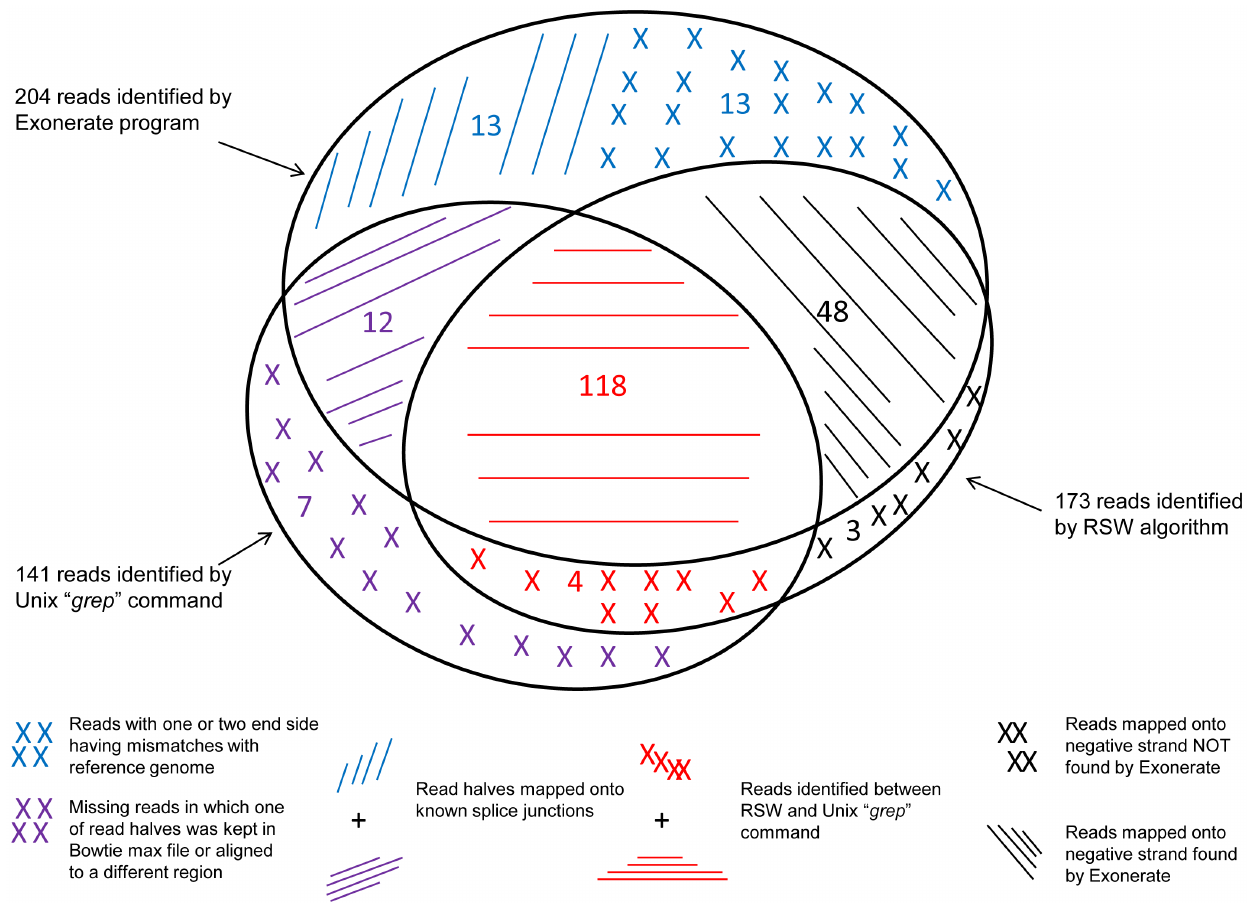
Figure 4. Comparison of supporting reads for Xbp1 ’s 26 nt splice junction site in the Dithiothreitol (Dtt) sample from RSW, Exonerate and the Unix ‘‘ grep ’’ command.